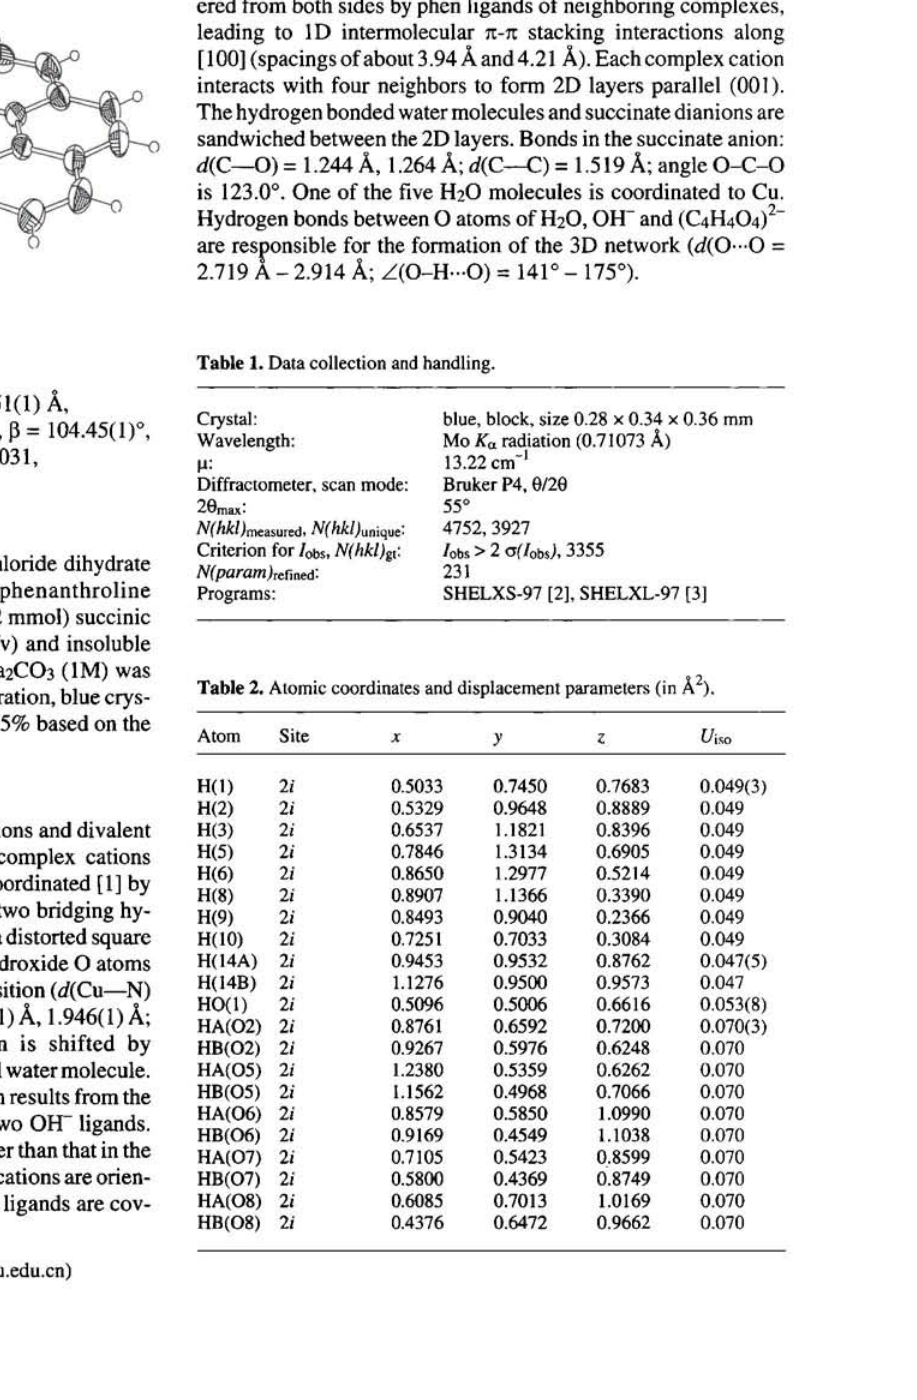
Table 1. Data collection and handling.